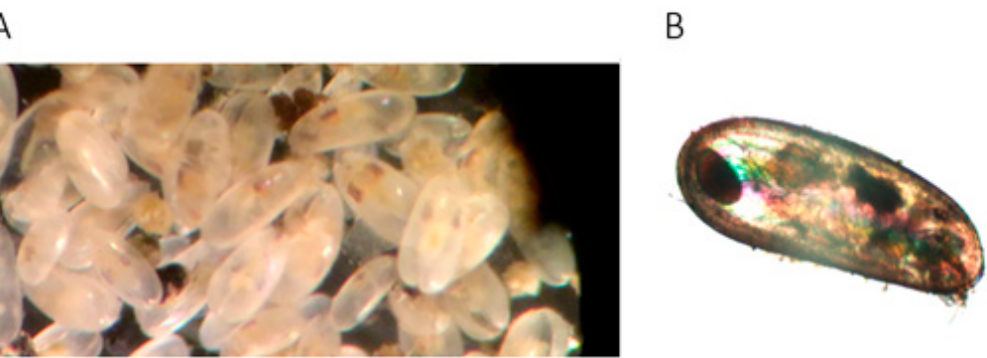
Figure 1. Darwinula stevensoni . ( A ) A sample of multiple individuals of Darwinula stevensoni . Taken by Jeroen Vendericks. ( B ) Lateral view of the carapace of an individual D . stevensoni . This picture was taken with the polychromatic polarization microscope [40] with a 4× objective lens and a DP73 camera. The total length of the animals is around 800 μ m. In the left corner, an embryo in the brooding pouch is visible.